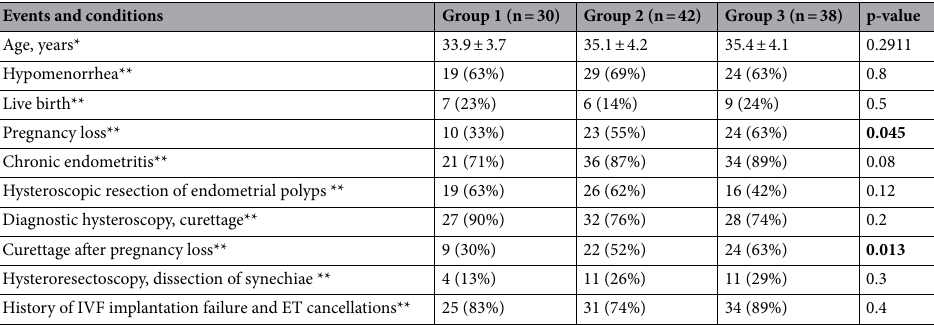
Table 1. Clinical history indicators for Groups 1–3. *the data are presented as mean ± SD, subject to ANOVA. **the data are presented as raw counts and % incidence, subject to exact Fisher test. Significant values are in bold.